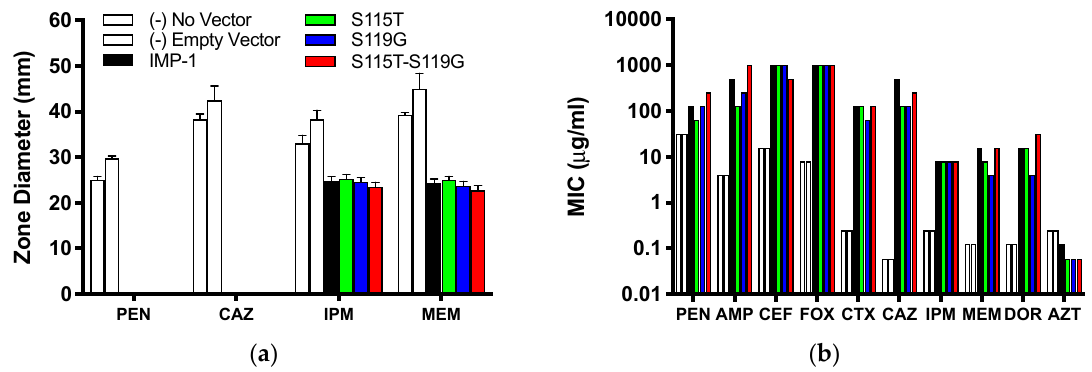
Figure 2. ( a ) Inhibition zone diameters observed in agar disc di ff usion assays with DH10B cells expressing the four di ff erent enzymes from the pBC SK( + ) vector and negative controls. Means ± standard deviations of four replicates are shown. ( b ) MICs of a range of β -lactam antibiotics. Cells, vectors, and color code for the di ff erent enzymes and controls are the same as in Panel ( a ). PEN = benzylpenicillin; AMP = ampicillin; CEF = cephalothin; FOX = cefoxitin; CTX = cefotaxime; CAZ = ceftazidime; IPM = imipenem; MEM = meropenem; DOR = doripenem; AZT = aztreonam. Median values of four replicates are reported. The values of AMP with IMP-1-S115T-S119G and FOX with all enzymes are ≥ 1024 µ g / mL, so they could be higher than graphed.